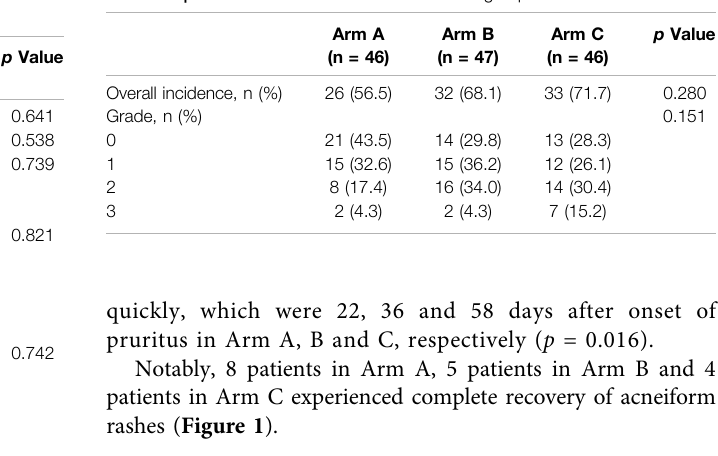
TABLE 2 | Incidence of acneiform rashes in each